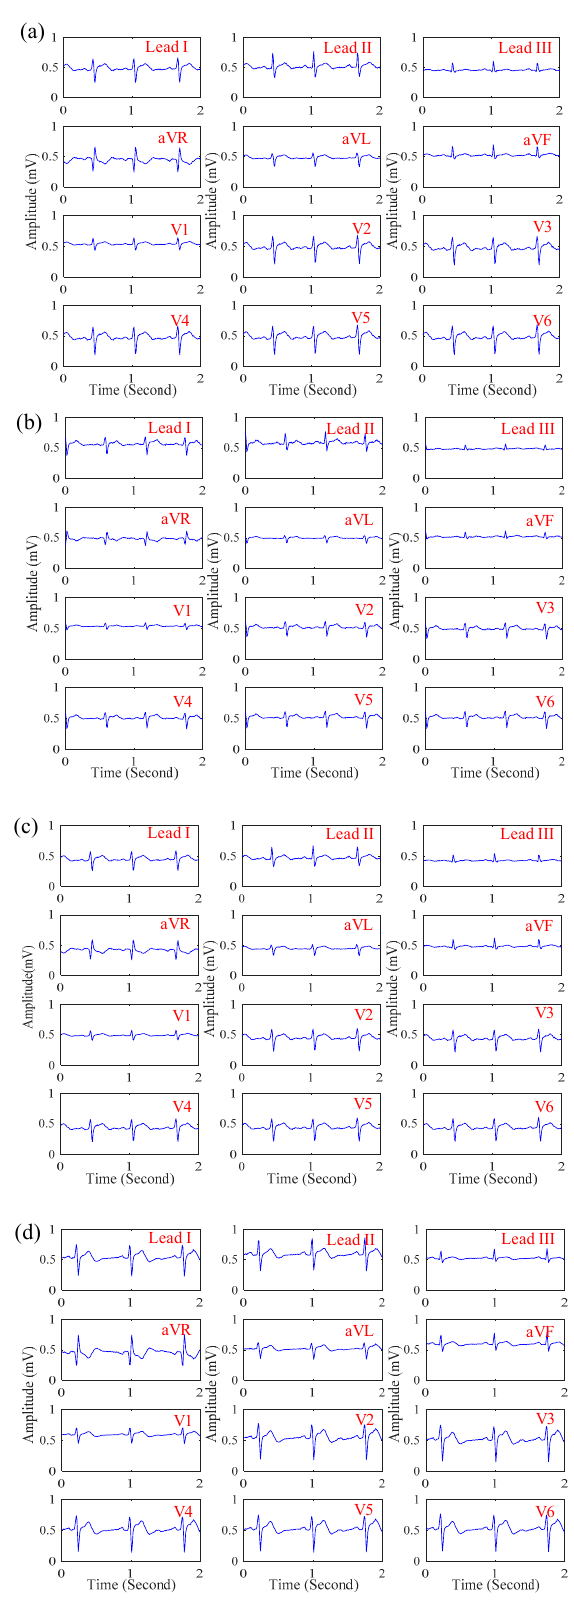
Figure 9. The 12-lead ECG signals obtained by the proposed system under different cloth conditions: ( a ) material: 100% cotton, thickness: 0.8 mm, dry; ( b ) material: 100% cotton, thickness: 1.4 mm, dry; ( c ) material: 80% cotton and 20% polyester, thickness: 0.8 mm, dry; ( d ) material: 100% cotton, thickness: 0.8 mm, sweating.